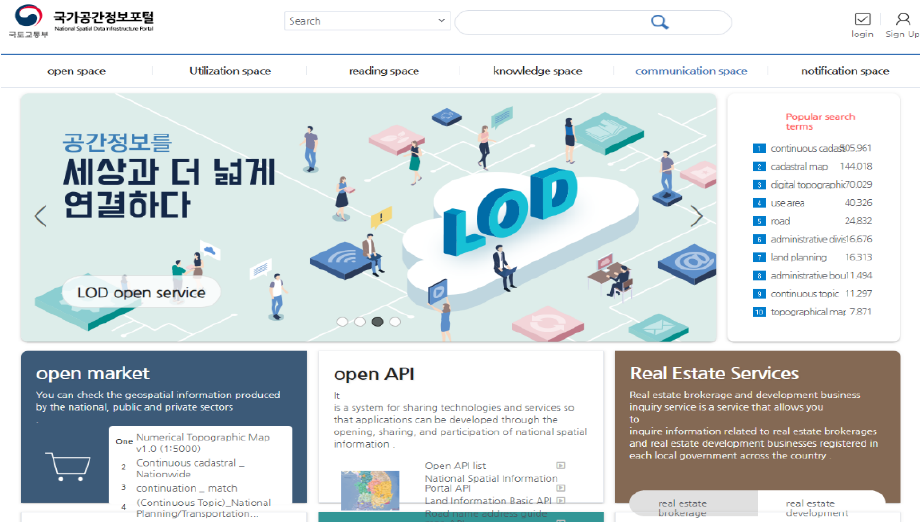
Figure 3. Main webpage of NSDIP.